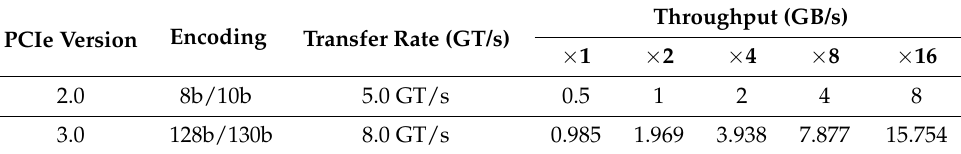
Table 1. PCIe throughput specifications.